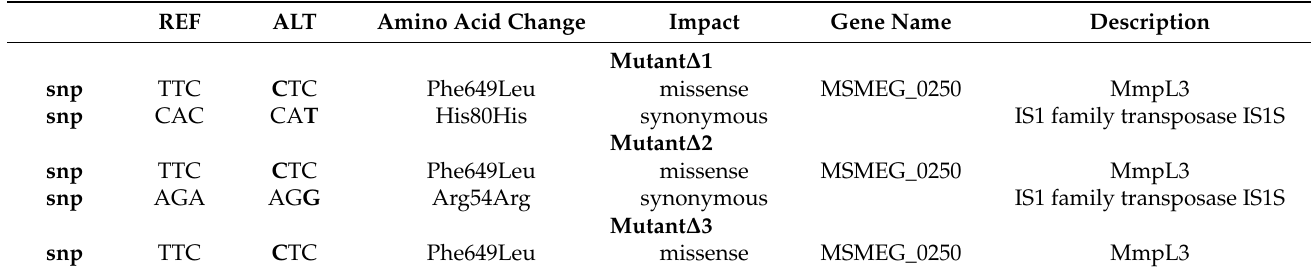
Table 4. Polymorphisms identified in M. smegmatis resistant